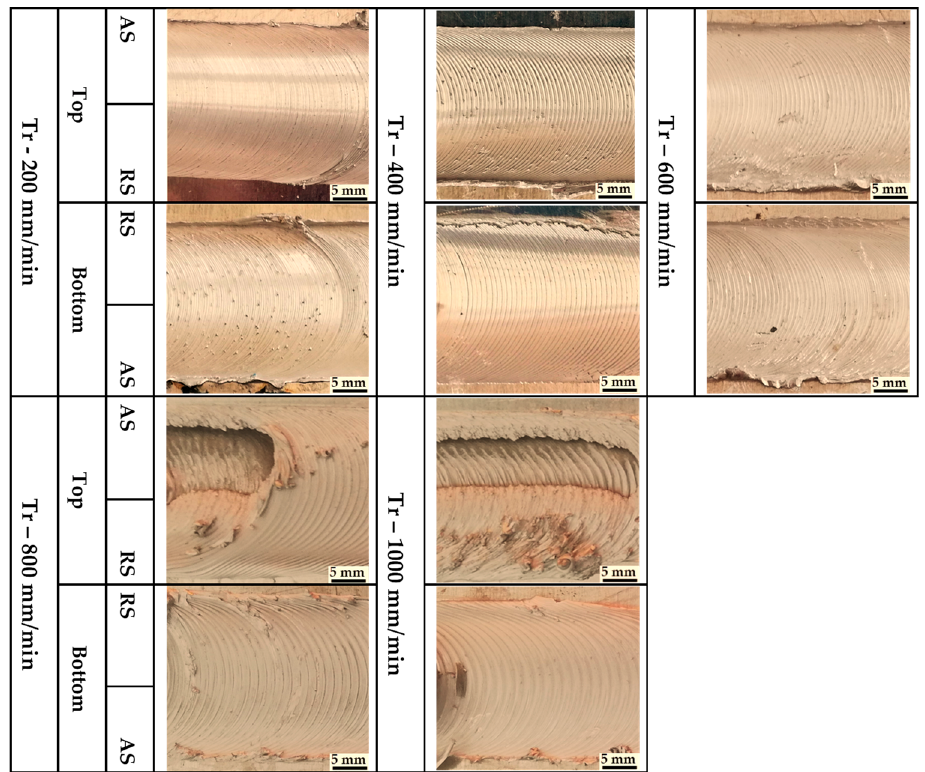
Figure 13. Top and bottom views of BT-FSW joints using Tr pin.